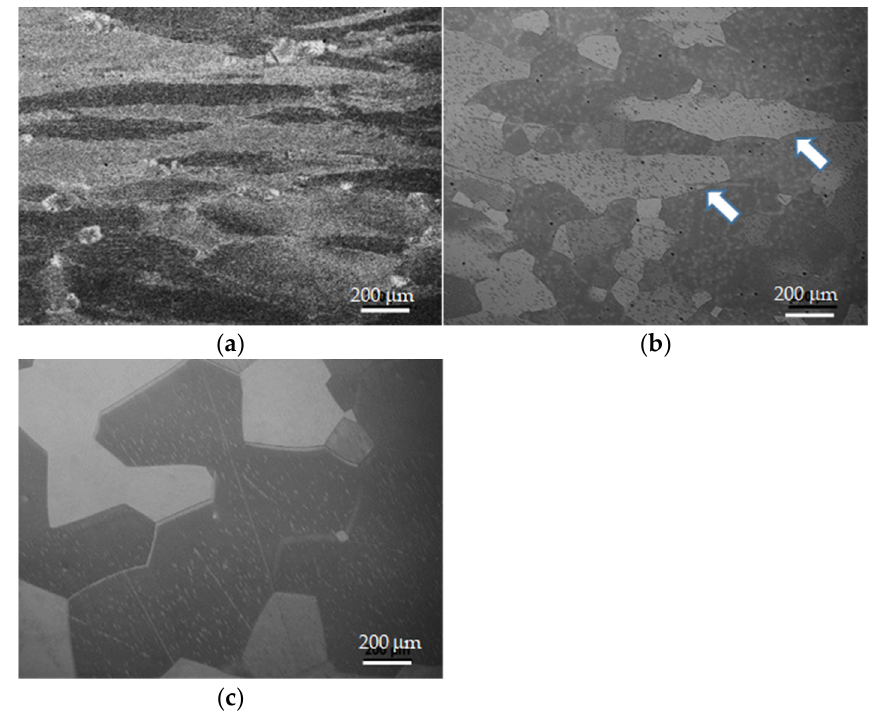
Figure 7. Optical micrographs showing the annealed microstructure at the centre region of Ti55511 cylindrical samples compressed to 60% reduction at 1100 ◦ C with 0.1/s and annealed for 1 h at ( a ) 800 ◦ C, ( b ) 900 ◦ C, and ( c ) 1000 ◦ C. The beta transus of Ti55511 is 870 ◦ C. Deformed (unrecrystal- lized) grains are pointed out by the white arrows in ( b ).